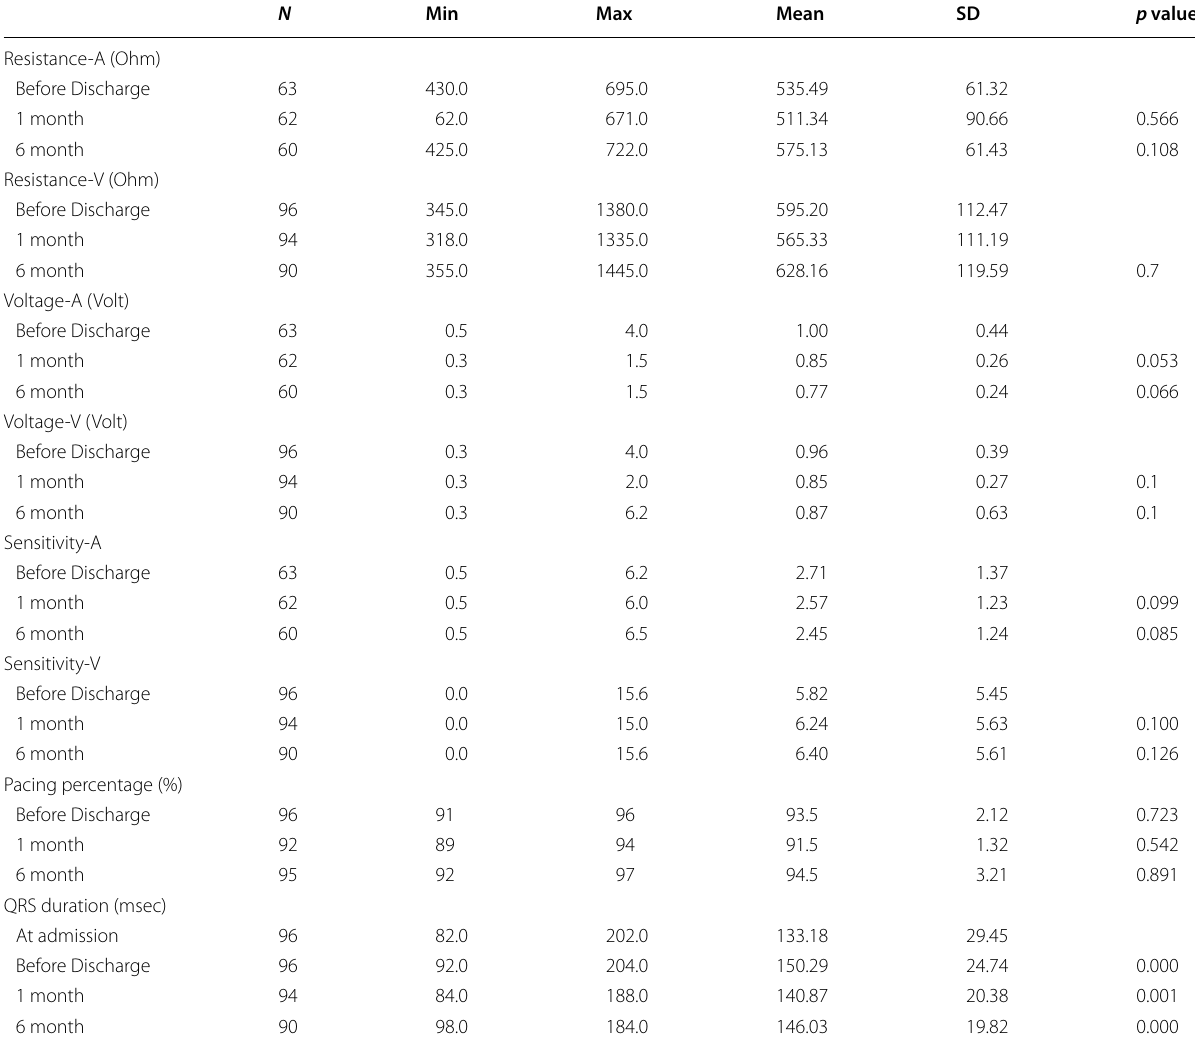
Table 2 Pacemaker parameters and QRS